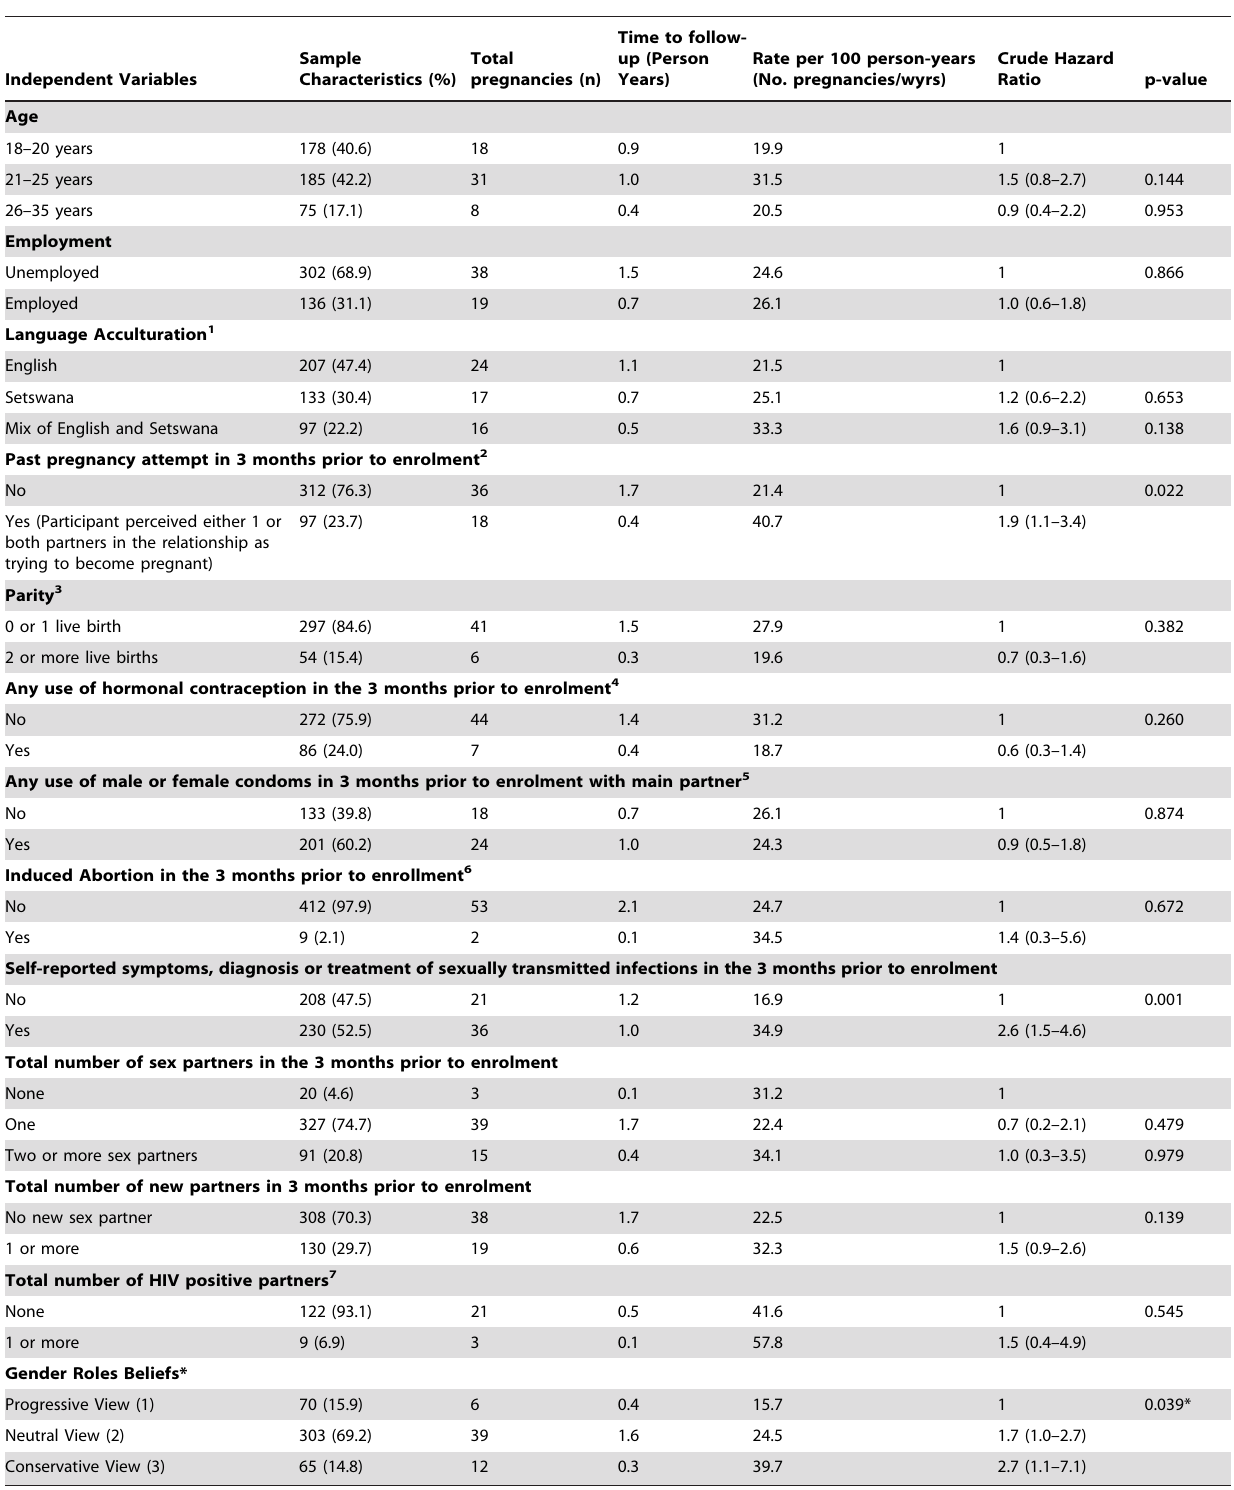
Table 1. Cohort description, pregnancy rate and associations with pregnancy incidence in HIV negative women (n=438; 57